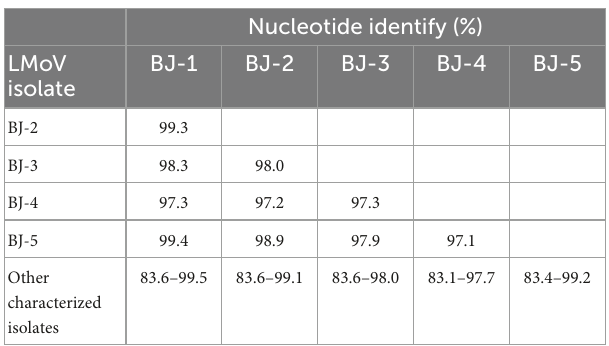
TABLE 6 Pairwise nucleotide sequence identify of genomic RNA of each LMoV isolate and the identity of each LMoV isolate with all other characterized isolates.